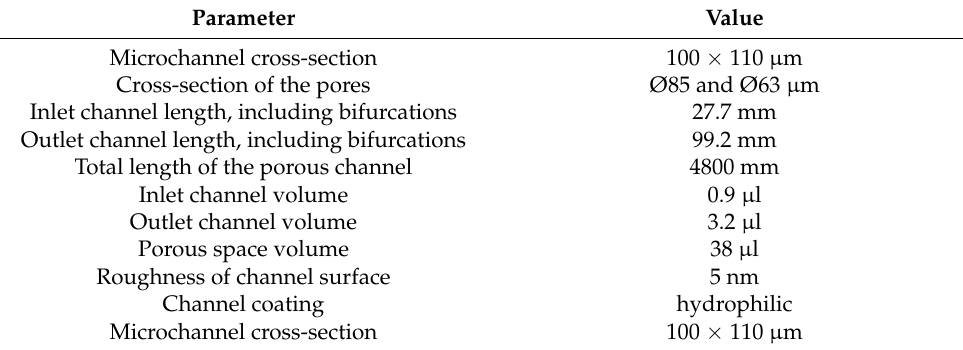
Table 2. Parameters of a porous microfluidic